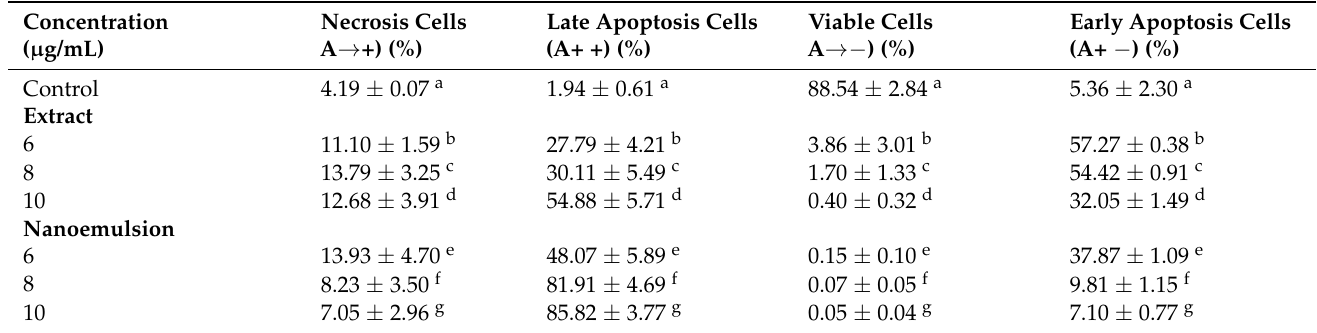
Table 6. Effect of different concentrations of xanthone extract and nanoemulsion on apoptosis of liver cancer cell HepG2 a